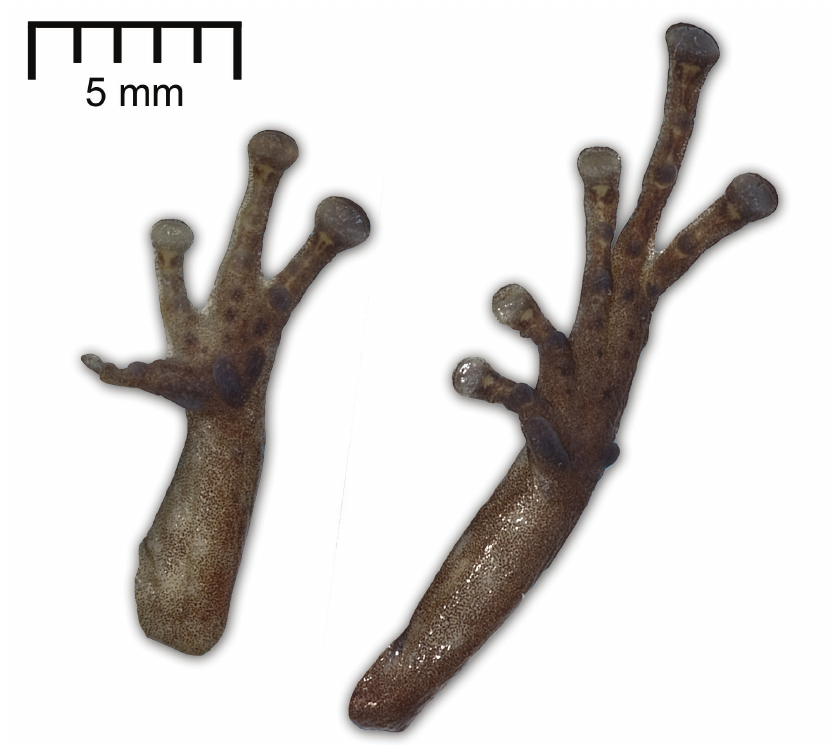
Fig. 9. Pristimantis imthurni sp. nov. Ventral view of left hand and left foot of the ♂ holotype (IRSNB 4165). Photographs by the